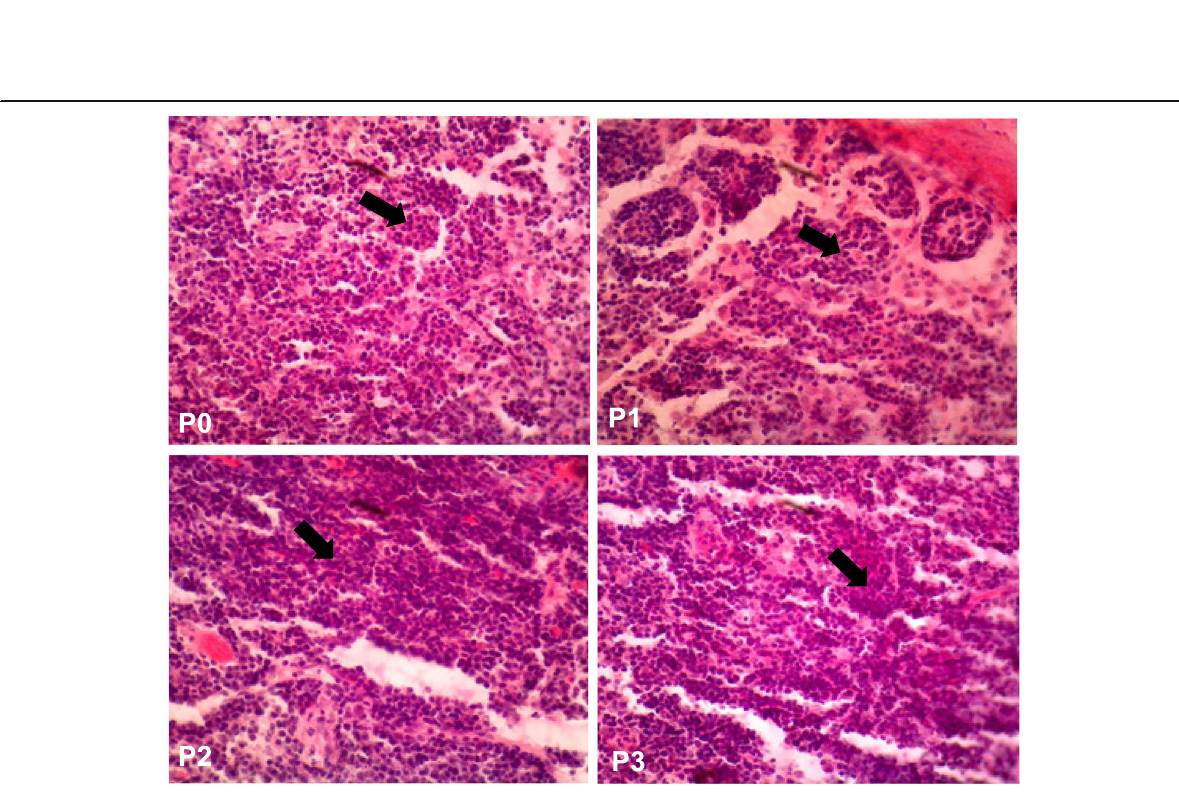
Fig. 4 Pancreatic histology in the rats given the ethyl acetate fraction of the Malaka flesh. Black arrow = pancreatic beta cell